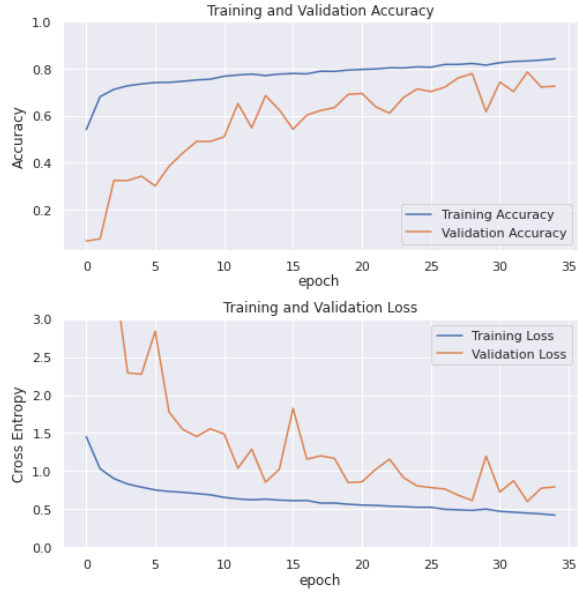
Figure 7. Accuracy on training and validation data during architecture